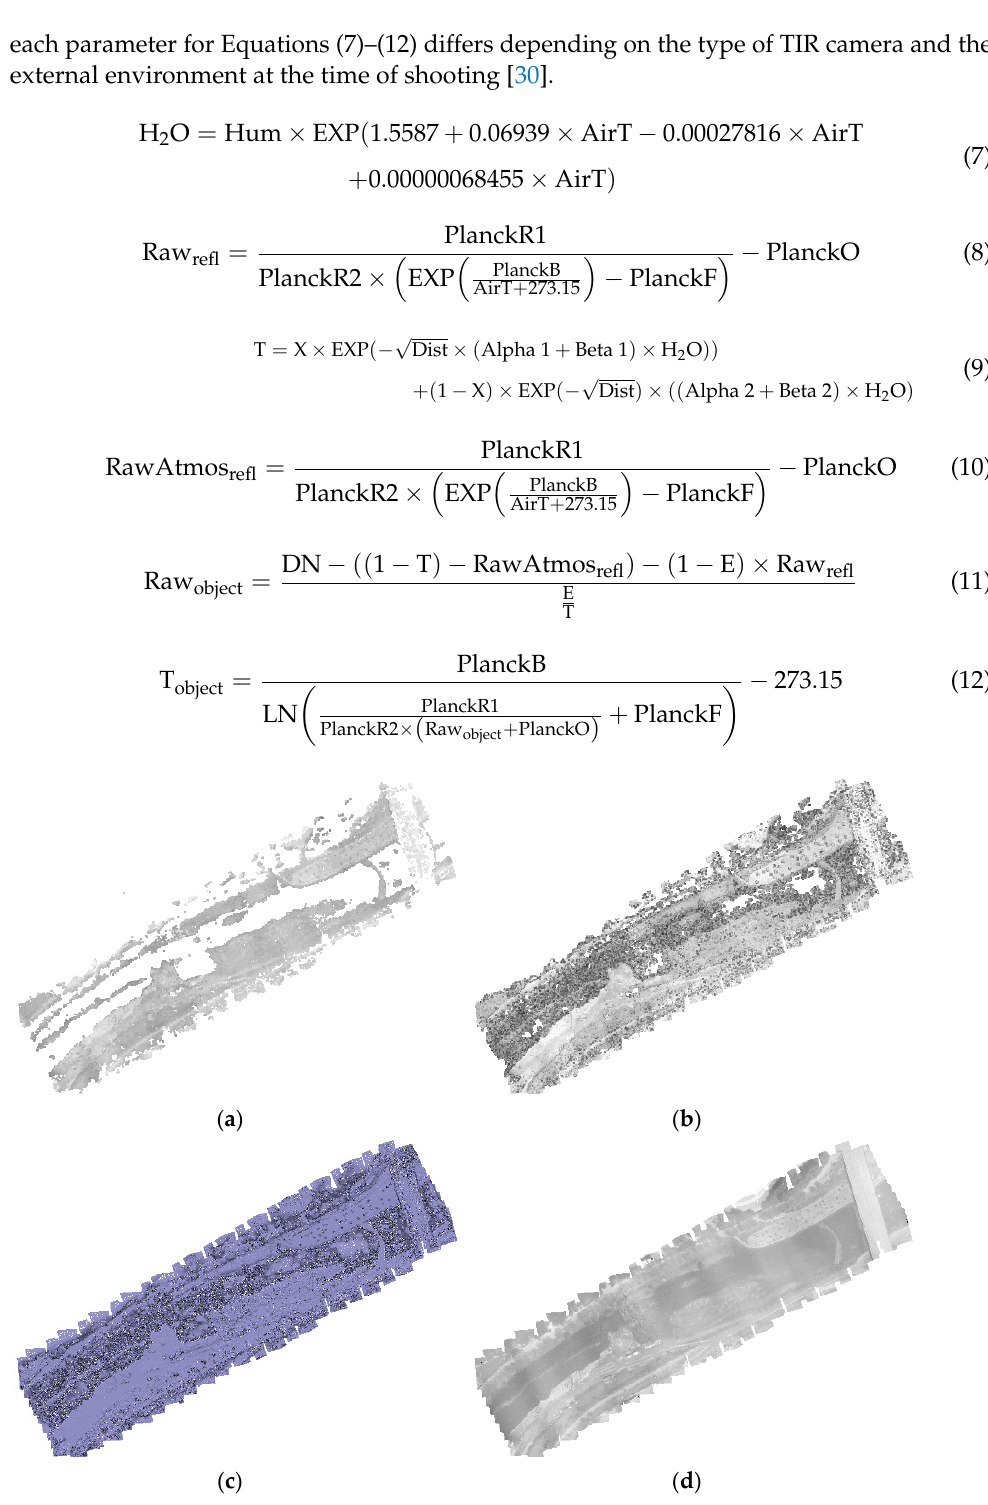
Figure 4. DN value orthophoto generation process before LST conversion (Shows an example of one orthophoto generation process out of a total of twenty-seven orthophotos.): ( a ) point cloud, ( b ) Dense cloud, ( c ) mesh, ( d ) Orthophoto with DN value. where, X, Y, and Z are the point coordinates in the local camera coordinate system; u The parameter information for the TIR camera requires PlanckR1, PlanckR2, PlanckB, and v denote the projected point coordinates in the image coordinate system (in pixels); f PlanckF, PlanckO, Alpha 1, Alpha 2, Beta 1, Beta 2, X [37]. These parameters are unique is the focal length; c x and c y are the principal point offset; K (cid:2869) , K (cid:2870) , K (cid:2871) , and K (cid:2872) are the values that are stored in the sensor to calculate atmospheric attenuation. This radial distortion coefficients; B 1 and B 2 represent the affinity and non-orthogonality (skew) coefficients, respectively; and w and h are the image width and height in pixels, respectively. Since the generated orthophoto is a DN value, it needs to be converted into a temperature value. The DN value was converted to a temperature value using Equations (7) to (12), and each parameter for Equations (7) to (12) differs depending on the type of TIR camera and the external environment at the time of shooting [30]. 𝐇 𝟐 𝐎 = 𝐇𝐮𝐦 × 𝐄𝐗𝐏(𝟏.𝟓𝟓𝟖𝟕 + 𝟎.𝟎𝟔𝟗𝟑𝟗 × 𝐀𝐢𝐫𝐓 − 𝟎.𝟎𝟎𝟎𝟐𝟕𝟖𝟏𝟔 × 𝐀𝐢𝐫𝐓 + 𝟎.𝟎𝟎𝟎𝟎𝟎𝟎𝟔𝟖𝟒𝟓𝟓 × 𝐀𝐢𝐫𝐓)